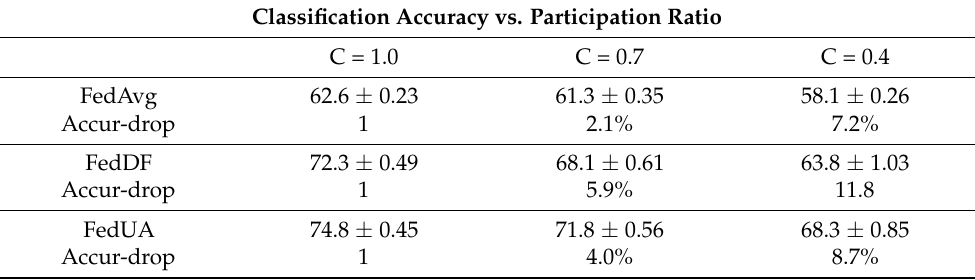
Table 3. The performances of FedAvg, FedDF, and FedUA under different participation ratios. (Accur-drop denotes the percentage of accuracy drop by taking C = 1.0 as the reference.) Classification Accuracy vs. Participation Ratio C = 1.0 C = 0.7 C = 0.4 FedAvg 62.6 ± 0.23 Accur-drop